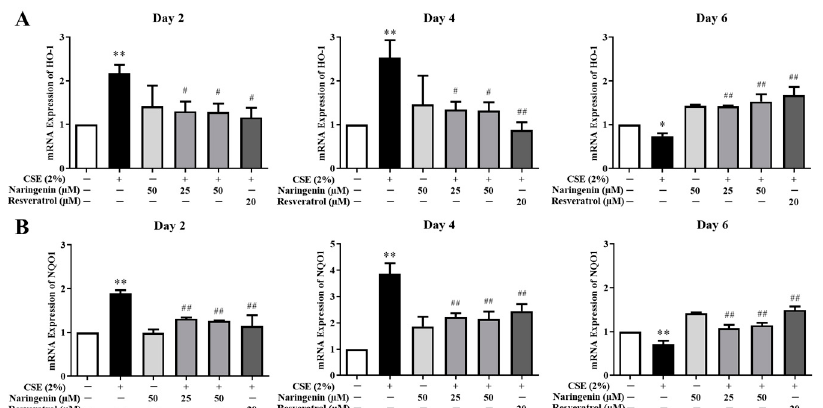
Figure 8. The effect of naringenin on CSE-induced mRNA expression of HO-1 ( A ) and NQO1 ( B ) in BEAS-2B cells. The expression value was normalized by the housekeeping gene β -actin. Data are expressed as the means ± SD of at least three independent experiments for each data point. * p < 0.05, ** p < 0.01 vs. Control; # p < 0.05, ## p < 0.01 vs. CSE alone group.